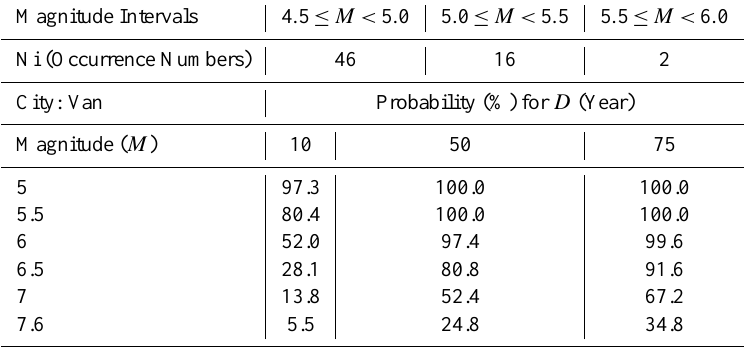
Table 3v. Earthquake occurrence probability (%) for D (Year) for Van city.